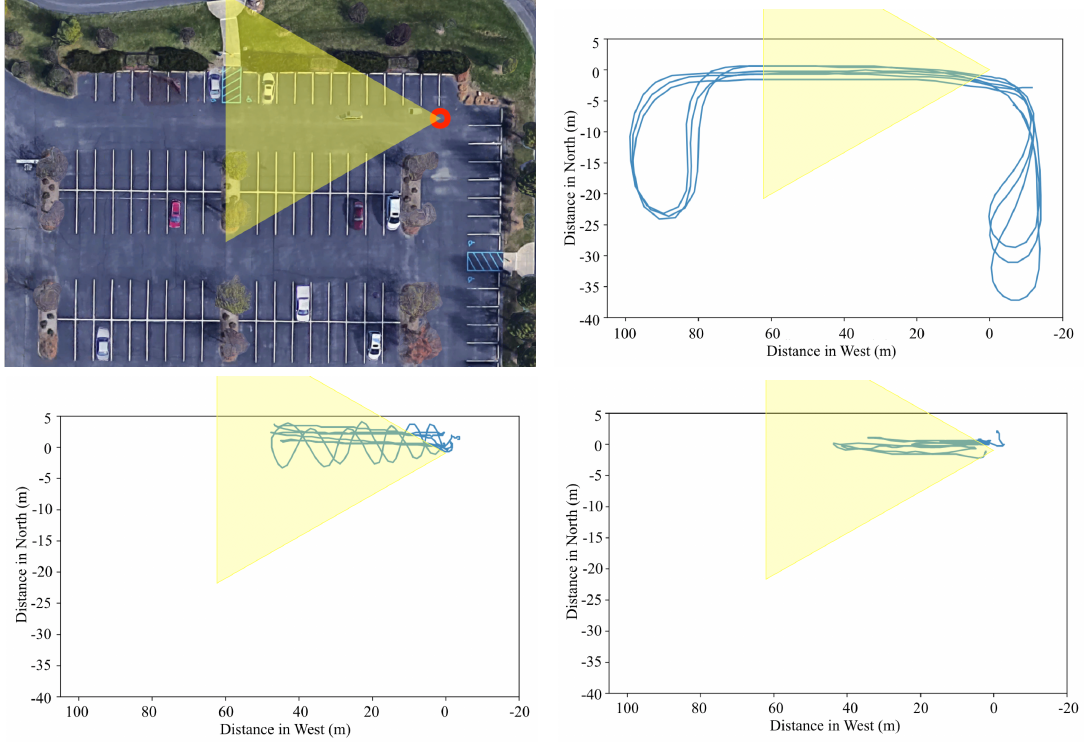
Figure 14. Plot of GPS tracking of each object at the park parking lot; the car, person, and drone in order of top right, bottom left, and bottom